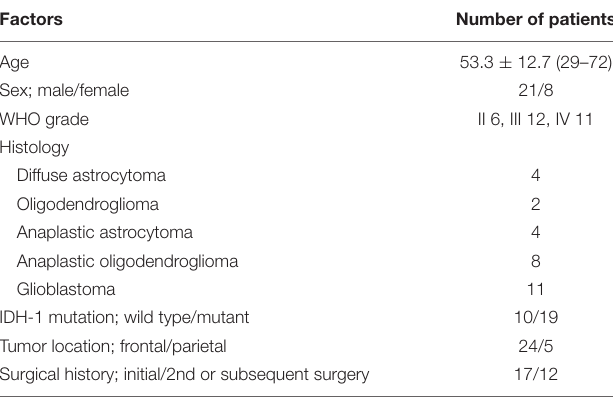
TABLE 1 | Demographic and clinical characteristics of participants who were intended to assess motor function. Factors